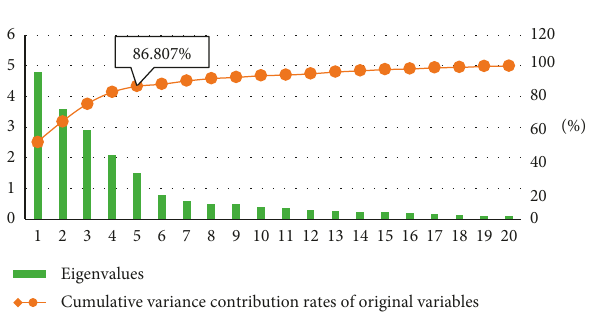
Figure 4: Scree plot chart of principal